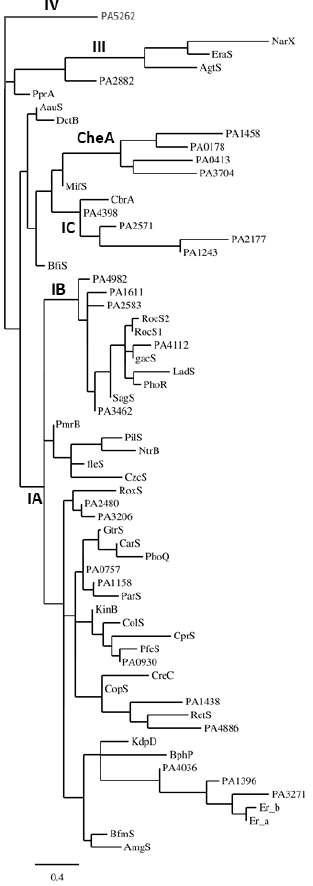
Figure 3. Phylogenetic analysis of the HKs of P. aeruginosa. Known HKs were aligned followed by phylogenetic analysis at Phylogeny.fr [93,94].